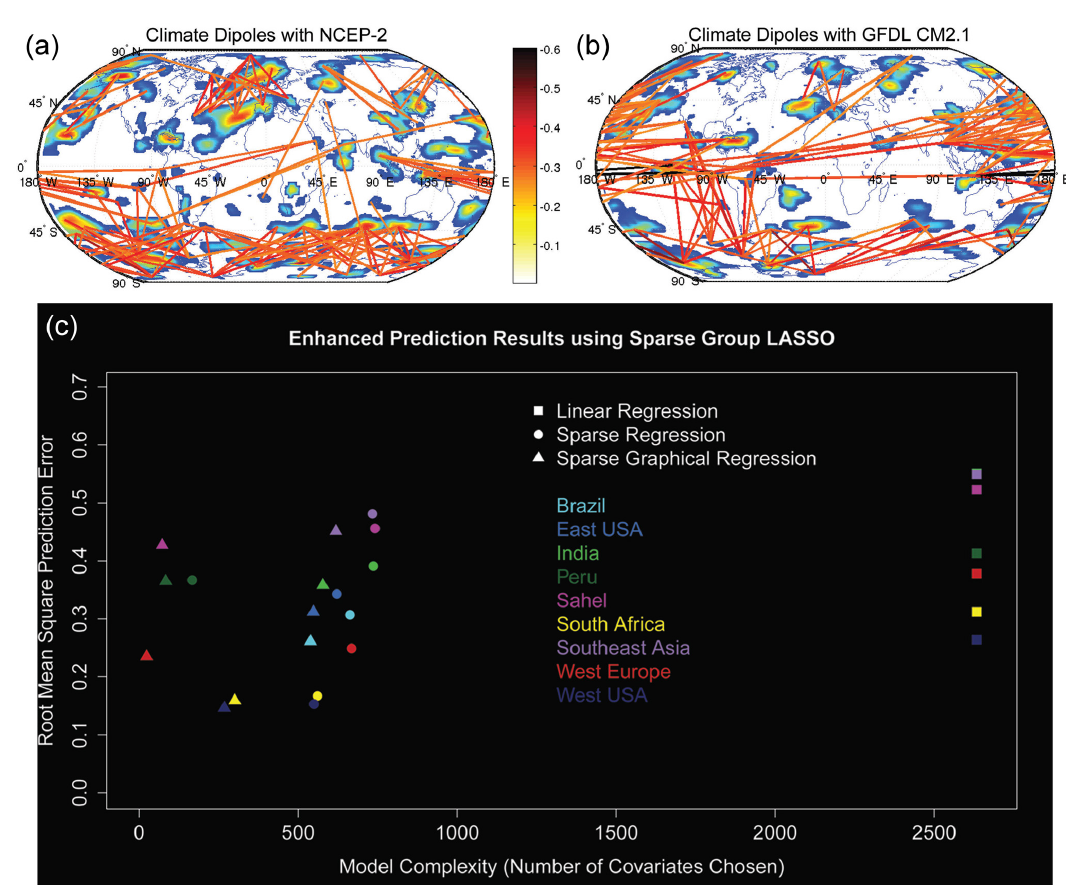
Figure 6. Predictive insights from observations and model simulations. (a) – (b) Dipoles were detected using sea level pressure (SLP) from NCEP2 reanalysis and the GFDL CM2.1 GCM from CMIP3 ( a and b , respectively) from the year 1979 to 2000. Dipoles are a class of teleconnections, or long-range dependence in space, that represent a persistent and large-scale temporal negative correlation in a given cli- mate variable between two neighboring or distant geographical locations. The dipoles shown here are generated using the shared reciprocal nearest neighbors (SRNN) algorithm graphical approach (Kawale et al., 2013). The edges of the graph, shown in the figure, represent dipole connections between two regions, while the color in the background shows the SRNN density, where darker colors signify regions of higher connectivity. This class of methods may be useful for systematically detecting, refining existing, or even identifying new, climate teleconnec- tions or oscillations, as well as for model evaluation. (c) While critical for statistical downscaling and relating ocean-based indices to regional land climatology, regression problems in climate may be particularly difficult to solve reliably, owing to issues like high dimensionality (large input variables compared to the number of calibration or training data), proximity-based spatial correlations, and teleconnections. Here we use multiple ocean variables (as predictors or covariates) to predict changes in land precipitation for multiple regions using NCEP1 reanalysis. The results indicate that a new approach, called the Sparse Group Lasso (SGL: Chatterjee et al., 2012), outperforms ordinary least squares and LASSO regressions (Tibshirani, 2011) as per both error-based predictive accuracy and model parsimony. Model parsimony refers to simpler models with lesser number of parameters, which in turn tend to generalize better than more complex models, especially if predictive accuracy on training data remains identical or also gets lower. Where climate extremes of interest (e.g., hurricanes or rainfall extremes) are projected less reliably but relate to variables (i.e., potential covariates) that are better projected (e.g., oceanic or land temperature), methods such as the SGL and future innovations may enhance projections beyond model simulations alone. We note that the ordinary least squares (OLS) approach serves only as a very naïve baseline for this analysis. In the OLS approach shown here, the number of covariates selected is simply all covariates considered; OLS intrinsically assigns non-zero coefficients to all covariates. With so many covariates, almost certainly the OLS model will have nonsensical non-zero parameters due to issues like multi-collinearity. We acknowledge the fact that procedures like stepwise least squares may improve on the naïve OLS reduce shown here by reducing the dimensionality of the problem. However, forward versus backward versus mixed stepwise procedures have their own set of problems related to multi-collinearity and changes in coefficients with addition or removal of covariates, among others. Still, we present the naïve all-covariate OLS purely as a baseline for comparison without implying that it is or should be used in high-dimensional problems of this